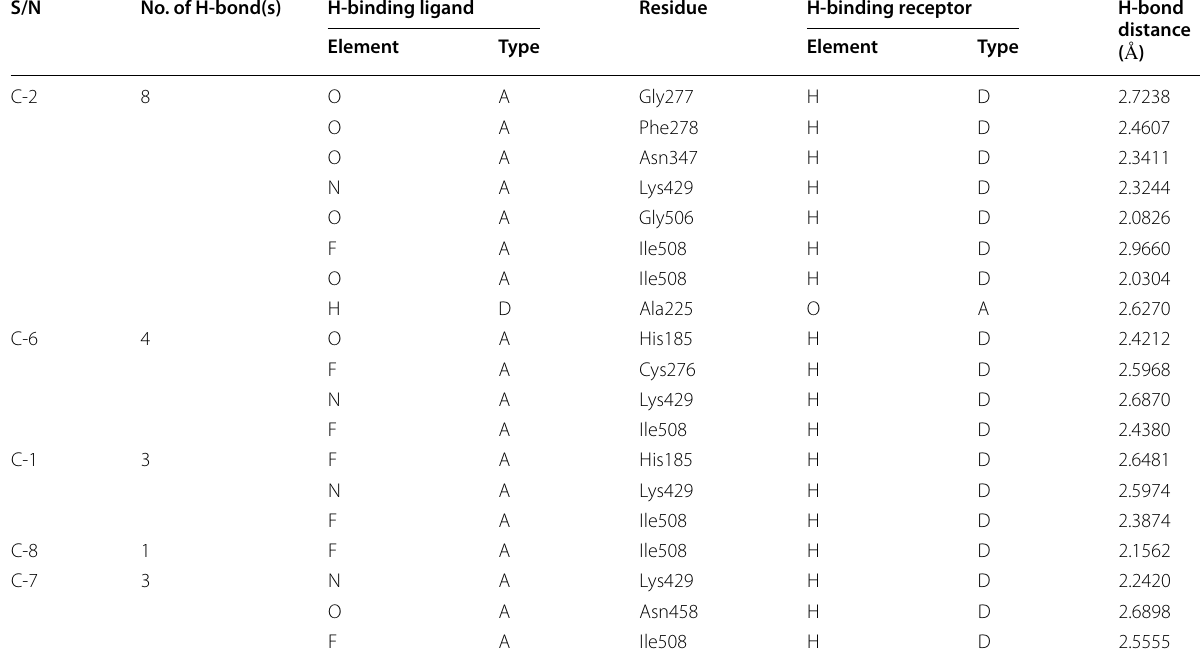
Table 6 Hydrogen bonding details between the protein receptor and five of the most active ligands